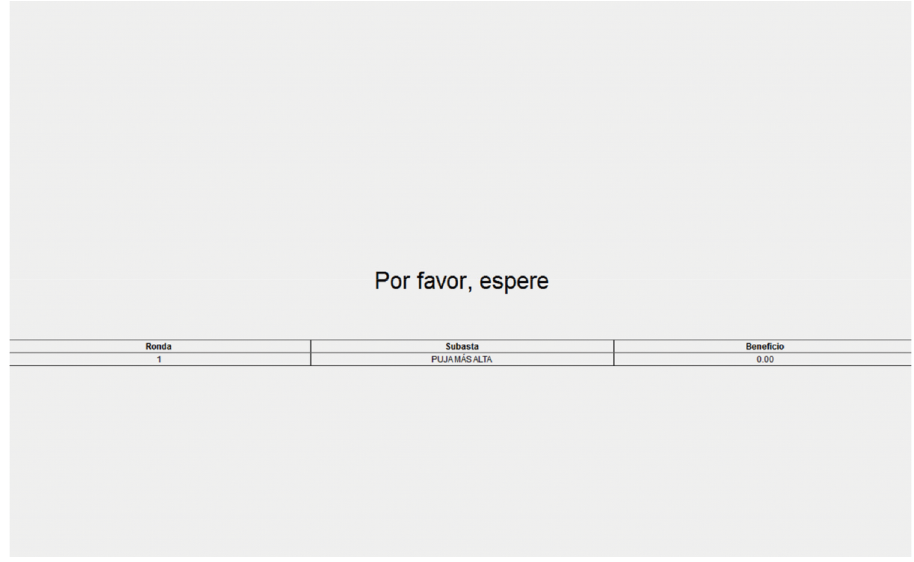
Figure A1.3. Wait